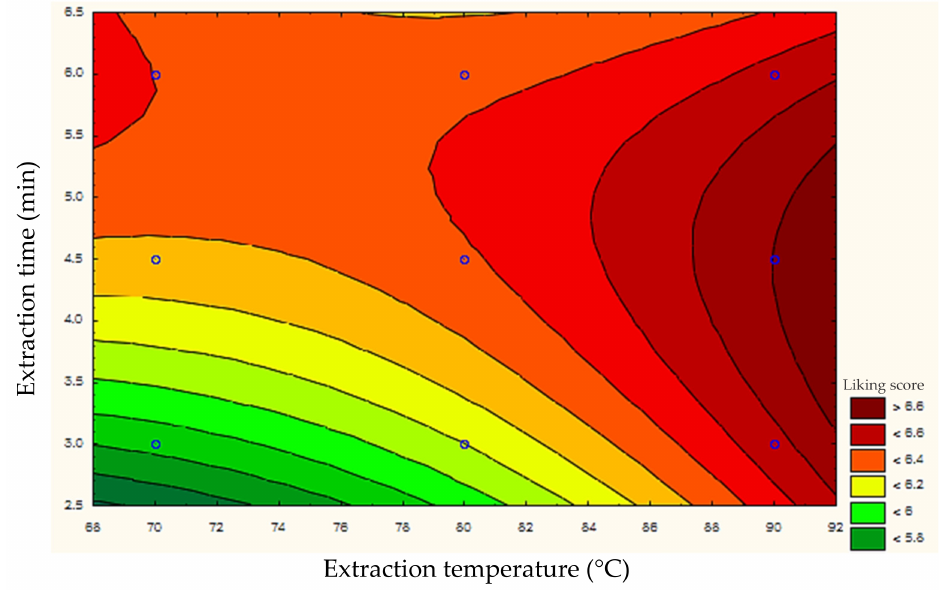
Figure 4. Contour plot for overall liking score as a function of extraction temperature and